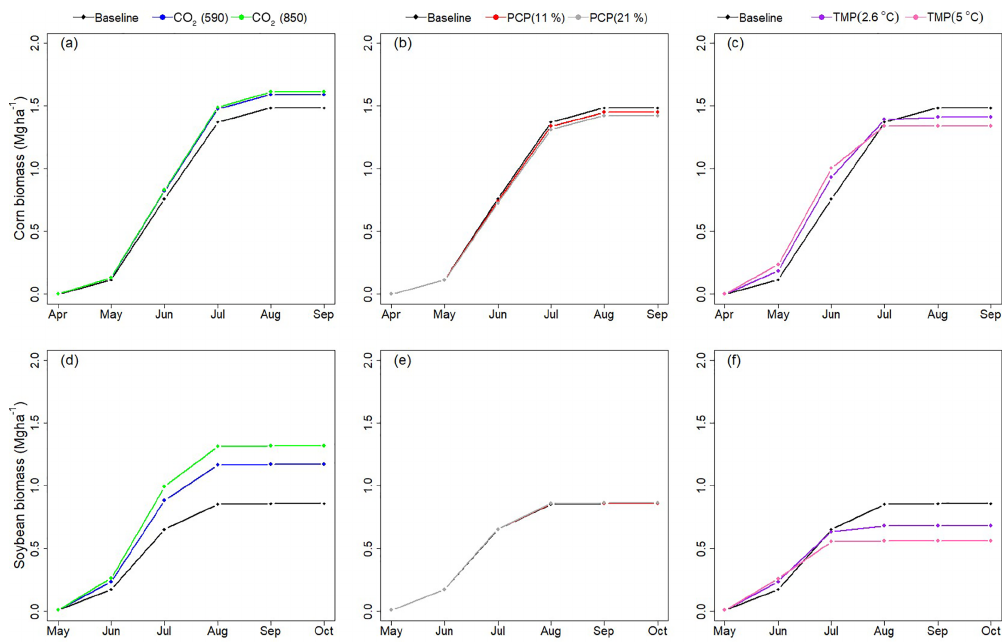
Figure 5. The responses of crop biomass growth to the climate sensitivity scenario: (a–c) corn and (d–f) soybean. Note: PCP and TMP in the legend stand for precipitation and temperature,